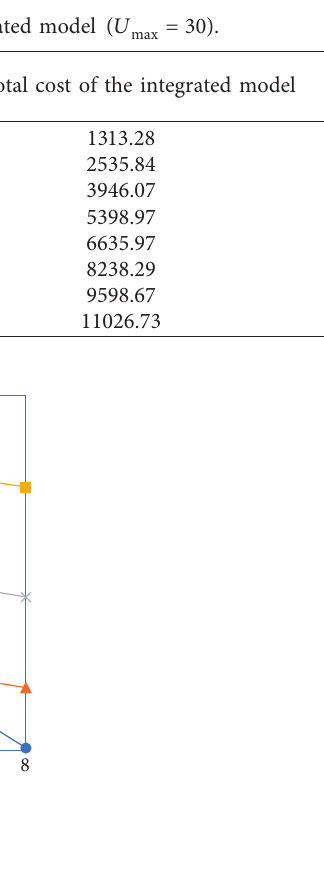
Table 8: The difference value between the periodic maintenance model integrated and integrated model ( N � 4). U max